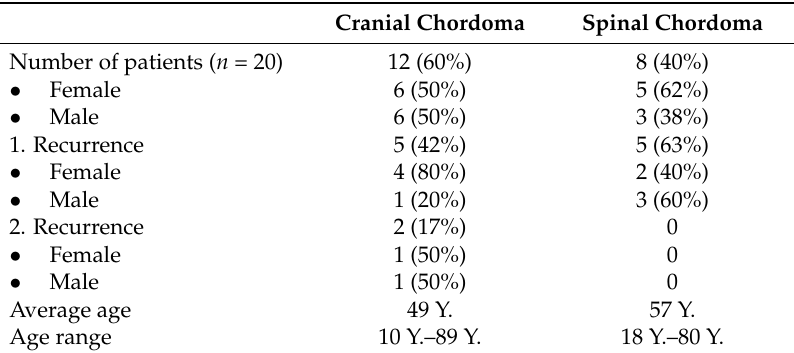
Table 1. Overview of the patient collective ( n =